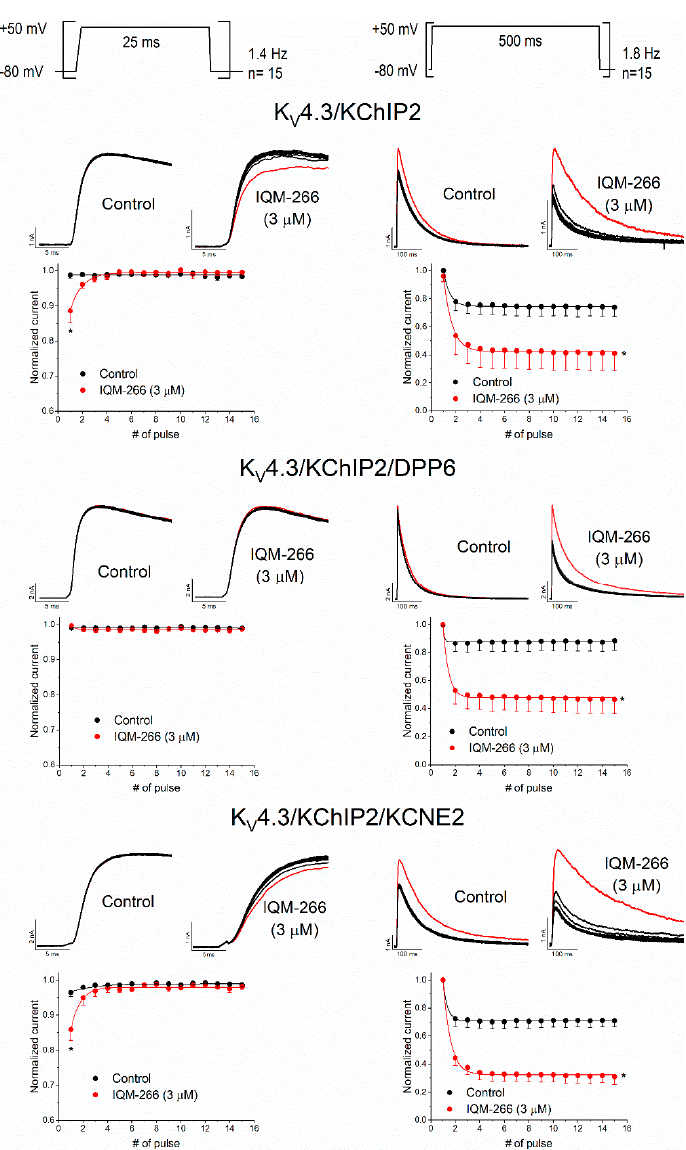
Figure 5. Use-dependent effects produced by IQM-266 on K V 4.3/KChIP2, K V 4.3/KChIP2/DPP6 and K V 4.3/KChIP2/KCNE2 channels after applying the two pulse protocols shown in the top of the figure. In the three panels, the top one shows current records obtained after applying the pulse protocols shown in the upper part of the figure. The red current represents the first current record of each train. Below the current records, the normalized current versus the first pulse is shown. Each point represents the mean ± S.E.M. of n = 5 cells (from n = 5 transfections) for K V 4.3/KChIP2 channels, n = 6 cells (from n = 5 transfections) for and K V 4.3/KChIP2/KCNE2 channels and n = 6 cells (from n = 5 transfections) of K V 4.3/KChIP2/DPP6 channels. *: p <